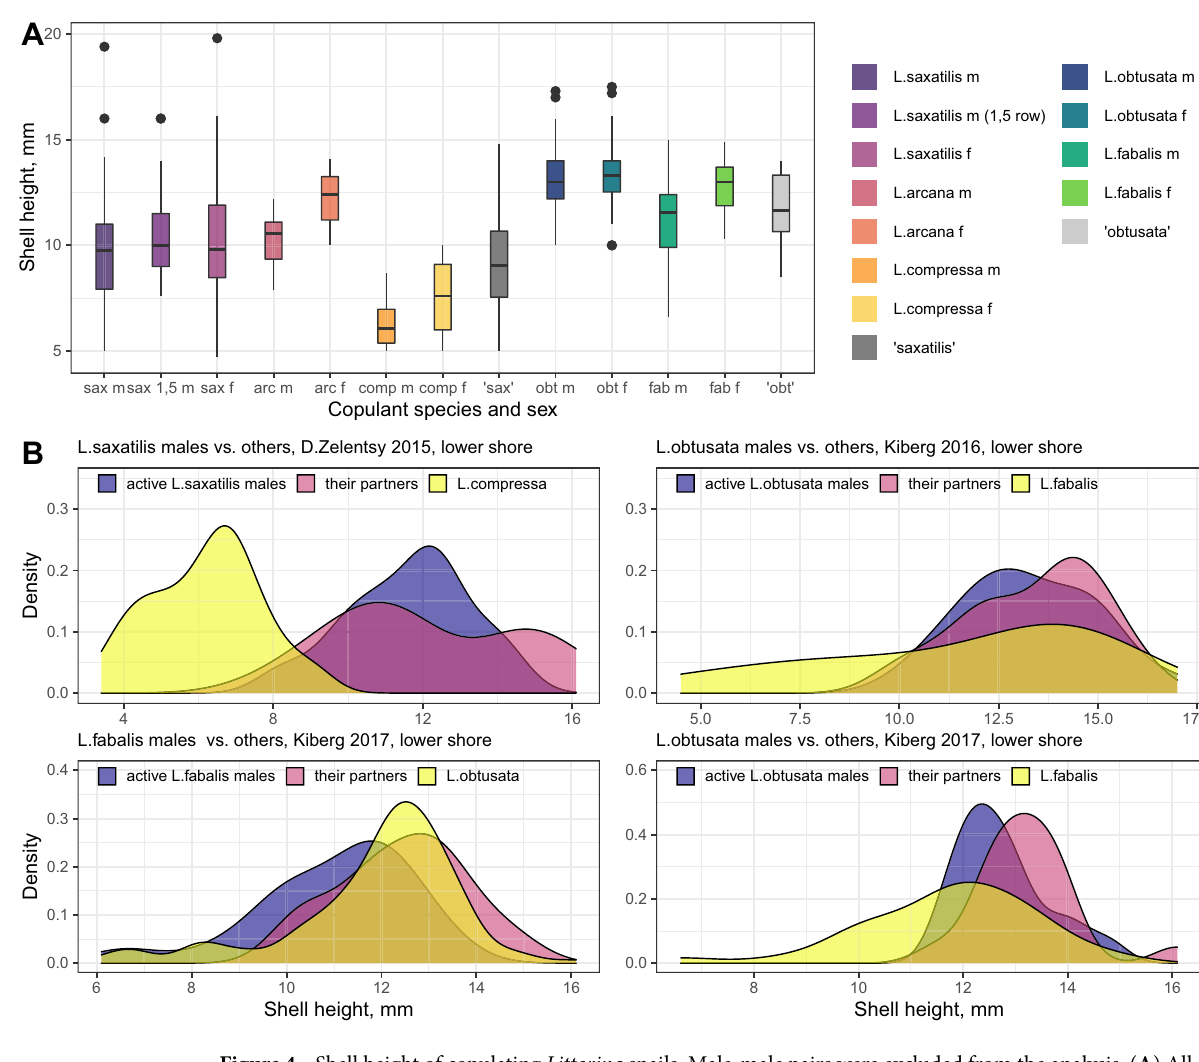
Figure 4. Shell height of copulating Littorina snails. Male-male pairs were excluded from the analysis. ( A ) All partners categorized by sex and species; data from different sites and levels were pooled. Dots indicate the values less or greater than 1.5 interquartile ranges from the median. ( B ) Shell height distributions illustrating potential for isolation by size in L. saxatilis vs L. compressa , L. obtusata vs L. fabalis (and vice versa); copulating males of the first species (violet), their passive partners (magenta, male-male pairs were excluded), and all collected individuals of the second species (yellow). All data on the size of mating and non-mating snails can be found in Supplement